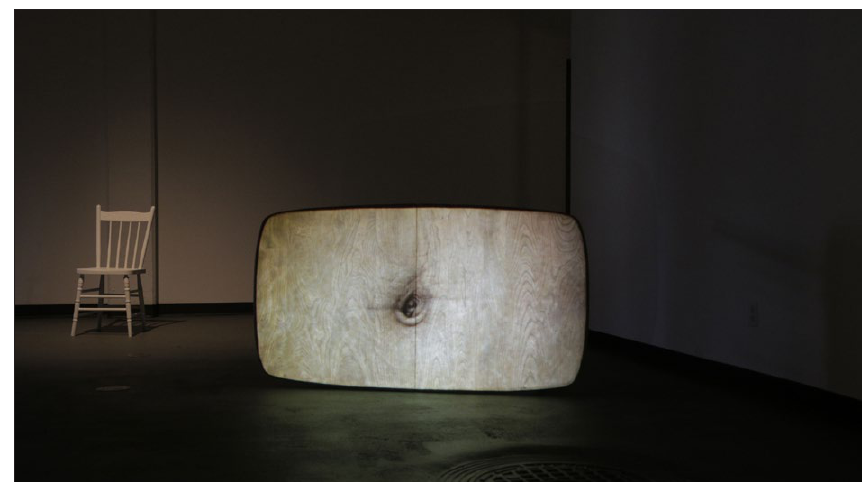
Figure 11: Farheen Haq, Feast, Wood table, projector, HD player, extension cord, 2015.